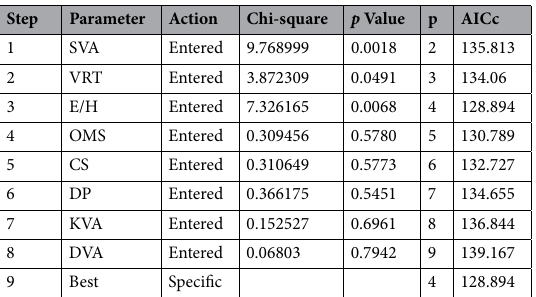
Table 5. Variable selection history. Abbreviations: SVA: static visual acuity, KVA: kinetic visual acuity, DVA: dynamic visual acuity, CS: contrast sensitivity, OMS: ocular motor skill, DP: depth perception, VRT: visual reaction time, E/H: eye hand